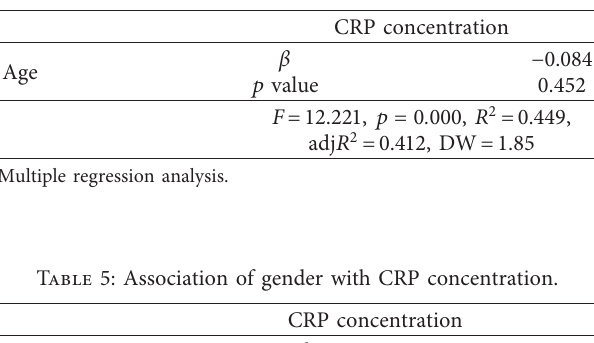
Table 5: Association of gender with CRP concentration. CRP concentration p value 0.881 Gender Men Women p value 2.08 ± 1.83 1.98 ± 2.86